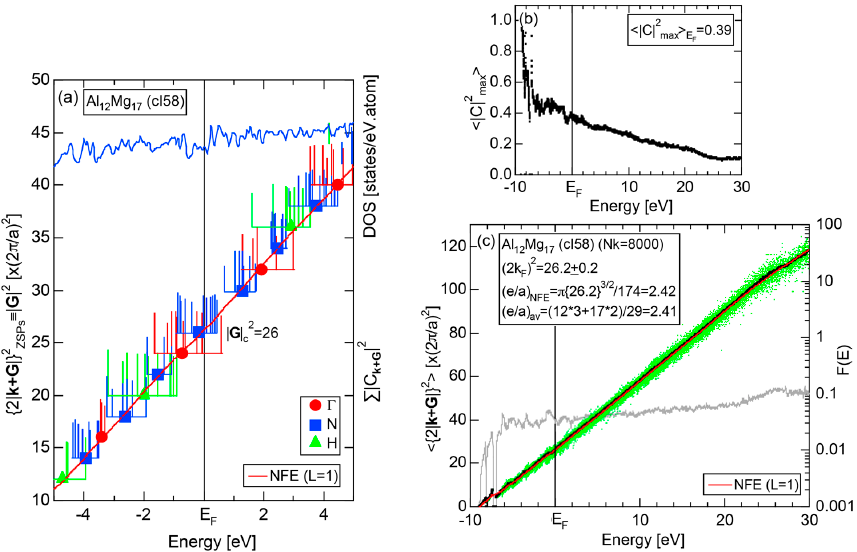
Figure 52. ( a ) FLAPW-Fourier spectra at symmetry points Γ , N, H of the bcc Brillouin zone along with total-DOS; ( b ) C max2 | C | 2 and ( c ) Hume-Rothery plot for Al 12 Mg 17 (cI58)